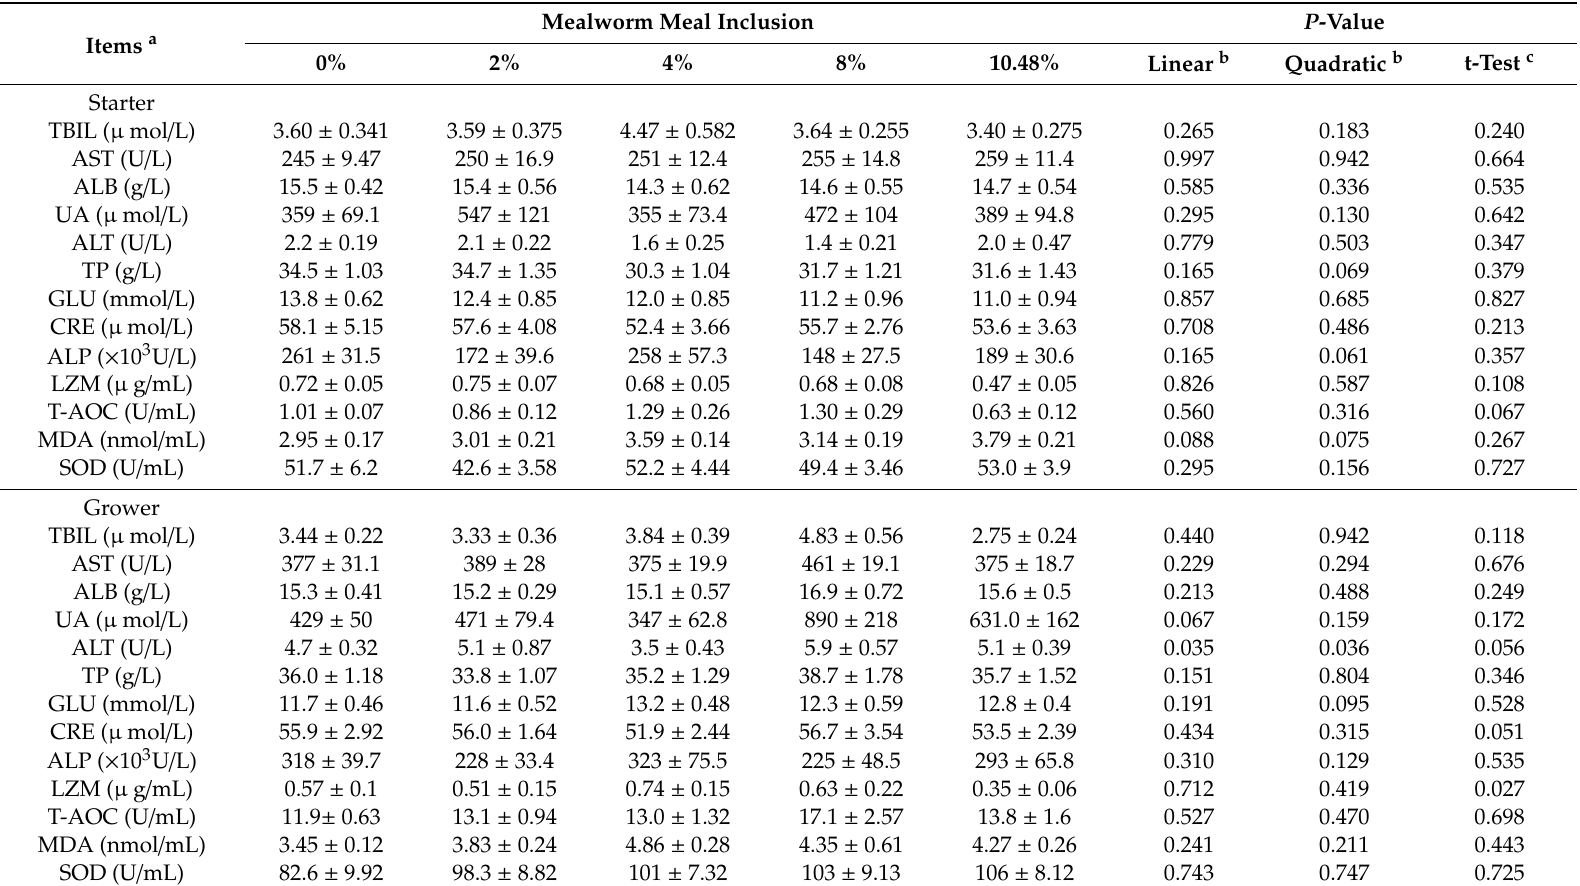
Table 4. Hematological characteristics of broiler chicks fed on MWM